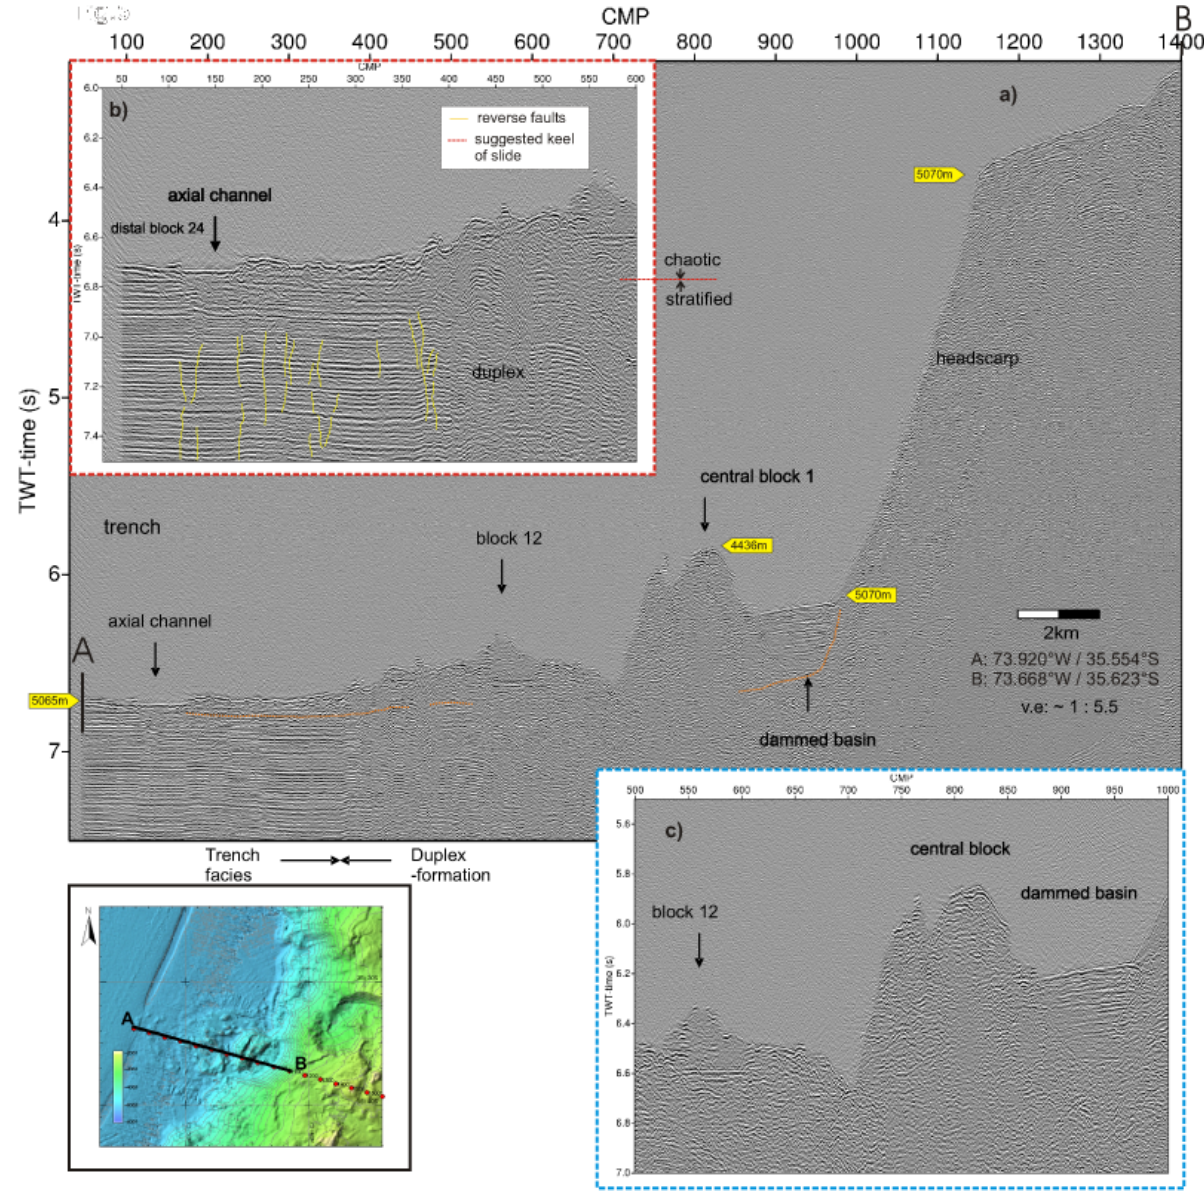
Fig. 5. Seismic profile P09 of RRS JAMES COOK expedition JC23b across Reloca Slide. Insert (b) shows the transition of undisturbed, parallel sediments of the trench facies to increasing compressional deformation when approaching the continental margin, as well as the transition of chaotic to well stratified strata that depicts the lower slide boundary. Insert (c) highlights the enigmatic sediment fill of the small basin in the back of slide block